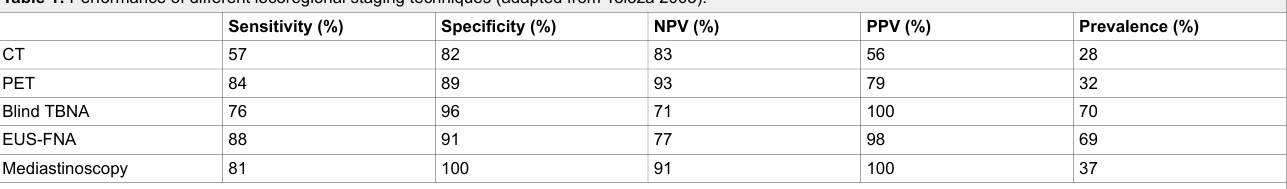
Table 1: Performance of different locoregional staging techniques (adapted from Toloza